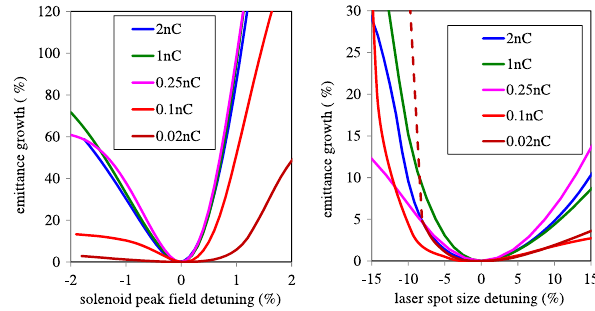
FIG. 9. Simulated emittance growth as a function of the sole- =B peak ; optimum (cid:2) 1 (left plot) and noid peak field detuning B peak z; z; solenoid solenoid as a function of the laser spot size detuning (cid:2) l xy =(cid:2) l; optimum xy (cid:2) 1 (right plot). The part of the curve for 0.02 nC shown with a dashed line corresponds to the case of the space charge limited emission when the desired bunch charge cannot be extracted from the cathode.